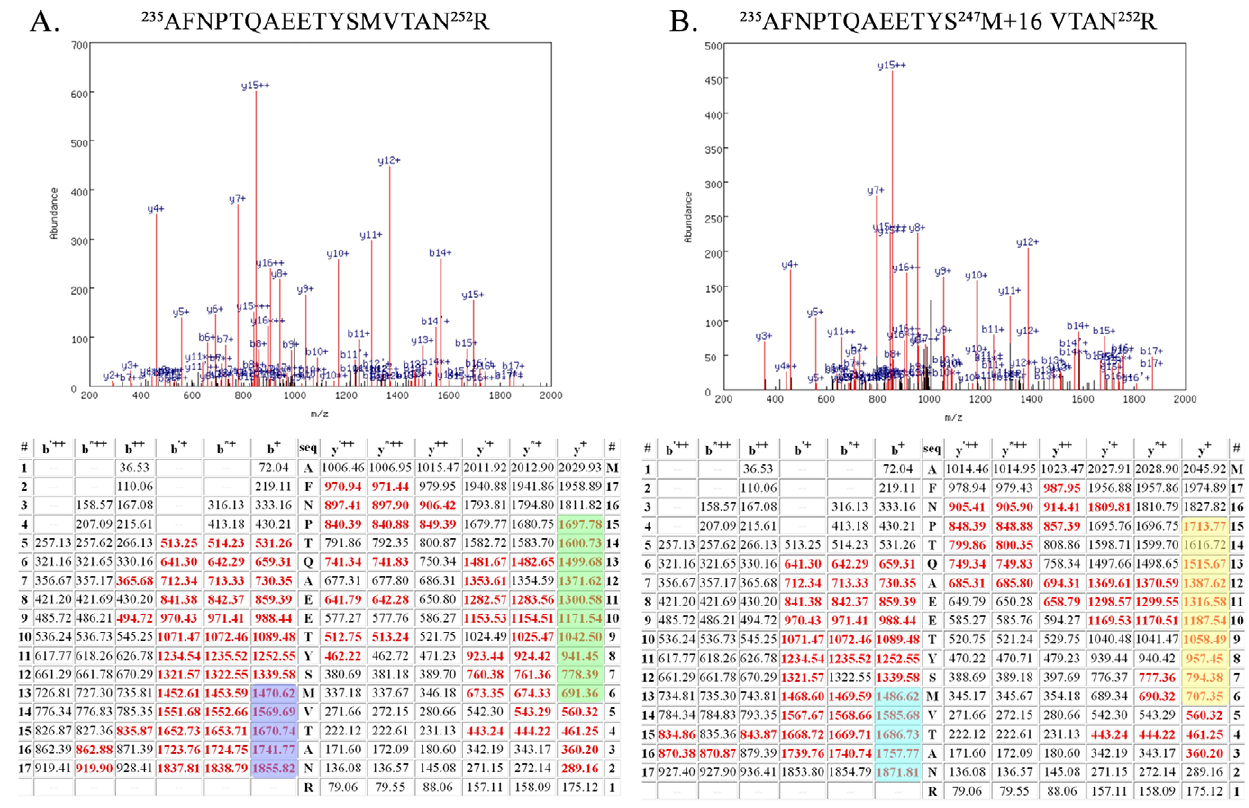
Figure 1. Example Mass Spectrometry Data from the Unmodified Peptide. 235 AFNPTQAEETYSMVTAN 252 R and the Oxidatively Modified Peptide 235 AFNPTQAEETYS 247 M + 16 VTAN 252 R of the D2 Protein A. Top, spectrum of the collision-induced dissociation (CID) of the unmodified peptide 235 AFNPTQAEETYSMVTAN 252 R. Various identified ions are labeled. Bottom, table of all predicted masses for the y- and b- ions generated from this peptide sequence. Ions identified in the CID spectrum (above) are shown in red. The b’ ++ , b’ + y’ ++ and y’ + ions are generated by the neutral loss of water while the b* ++ , b* + y* ++ and y* + ions are generated from the loss of ammonia. B. Top, spectrum of the CID dissociation of the modified 235 AFNPTQAEETYS 247 M + 16 VTAN 252 R. Various identified ions are labeled. Bottom, table of all predicted masses for the y- and b- ions generated from this peptide sequence. Ions identified in the CID spectrum are shown in red. The b’ ++ , b’ + y’ ++ and y’ + ions are generated by the neutral loss of water while the b* ++ , b* + y* ++ and y* + ions are generated from the loss of ammonia. For comparison the b 13 + –b 17 + ions of the unmodified peptide are highlighted in blue and those of the modified peptide are highlighted in cyan. All b ions longer than b 12 + in the modified peptide are 16 Da larger than the corresponding ions observed from the unmodified peptide. This indicates that 247 M contains an oxidative modification. Additionally, the y 6 + –y 15 + ions of the unmodified peptide are highlighted in green, while those of the modified peptide are highlighted in yellow. All y ions longer than y 5 + in the modified peptide are 16 Da larger than the corresponding ions observed from the unmodified peptide. This verifies that 247 M contains an oxidative modification. The p values for the unmodified and modified peptide were 10 2 13 and 10 2 11 , respectively.